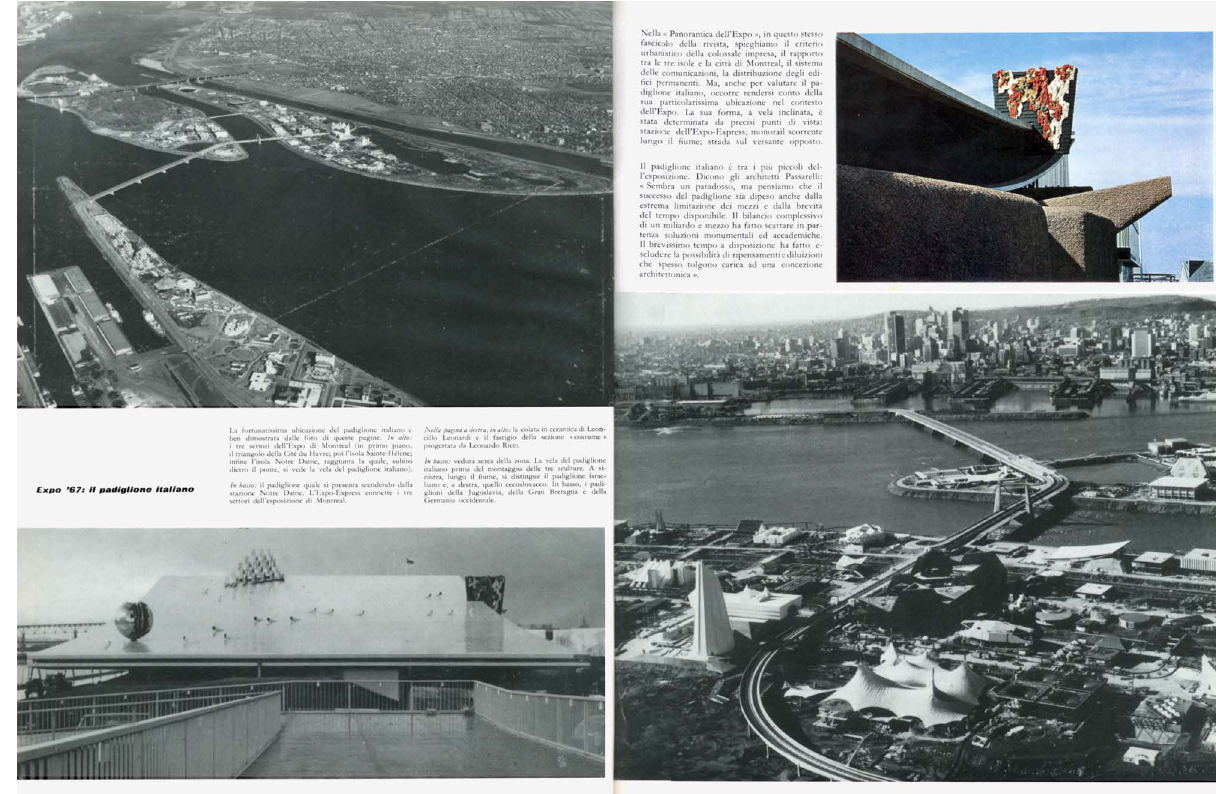
Fig. 5 Some views of the Italian pavilion. From L’architettura. Cronache e storia 13, no. 141 (July